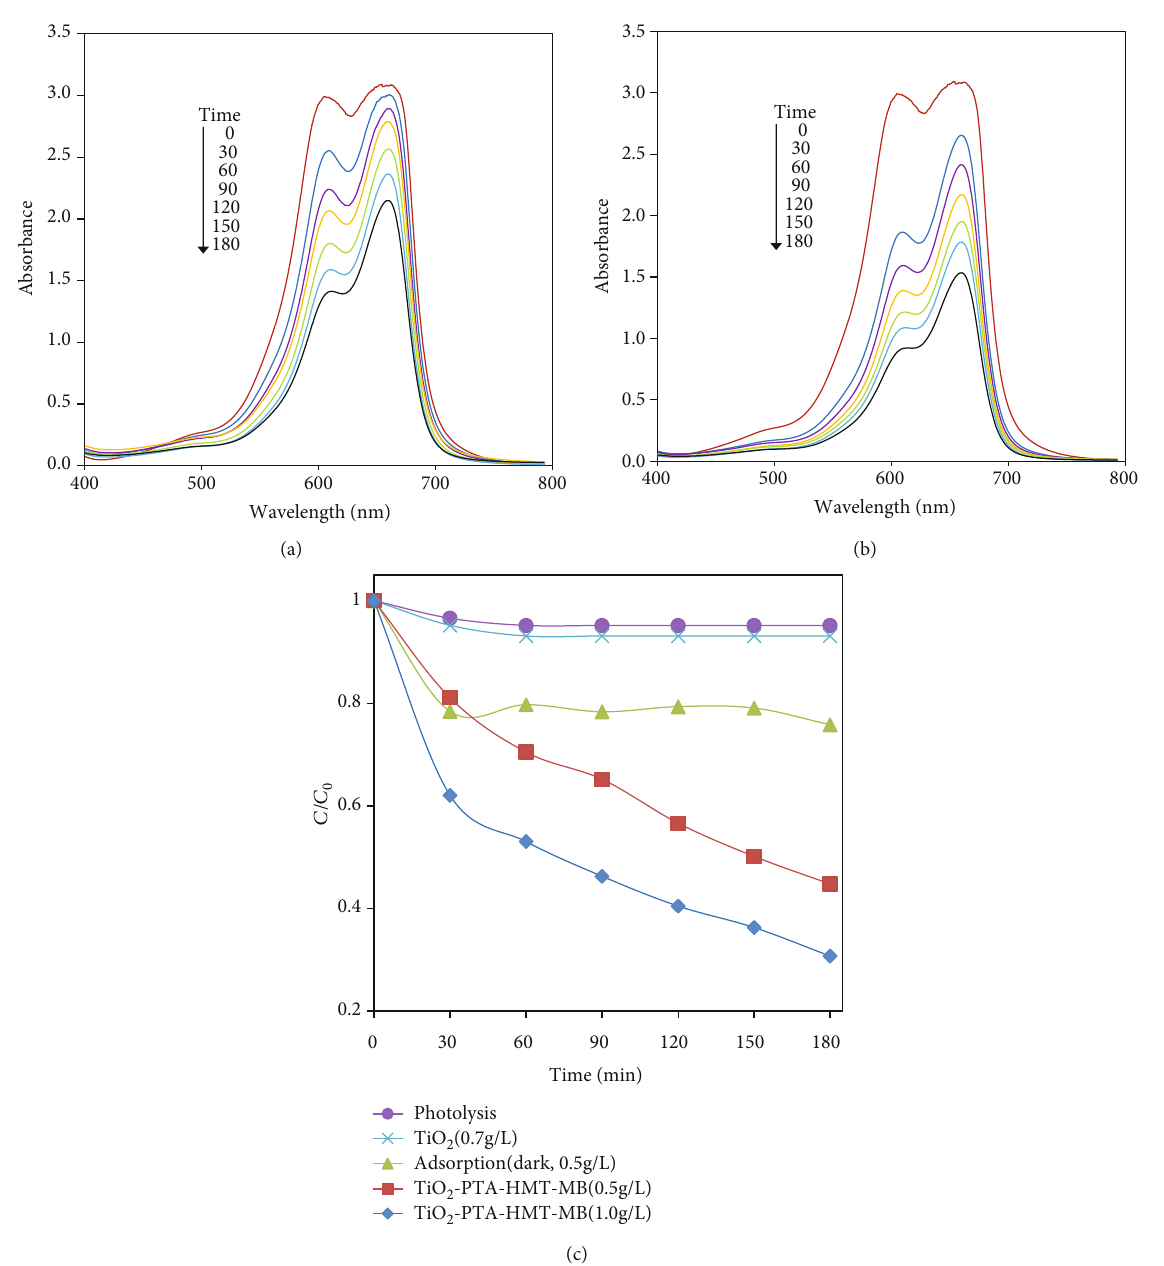
Figure 5: UV-Vis absorption spectra of MB (30 mg/L, pH = withoutadjustment = 5 : 7 ) during the photodegradation under visible light in the presence of TiO -PTA-HMT-MB (0.5g/L) (a), (1.0 g/L) (b), and C / C 2